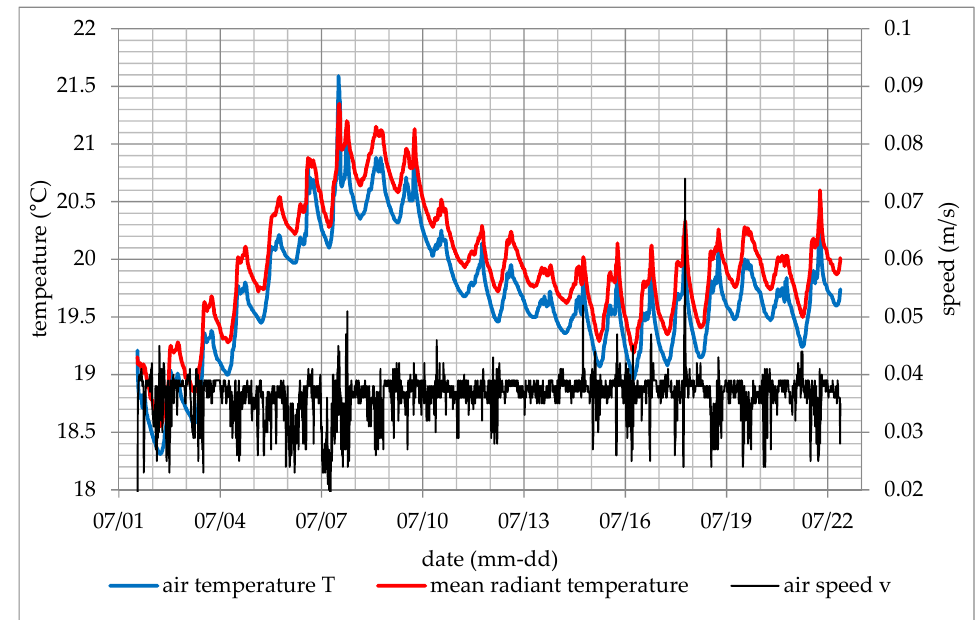
Figure 9. Indoor air temperature, speed, and mean radiant temperature measured next to the blackboard (sensor: T, Tr, V).